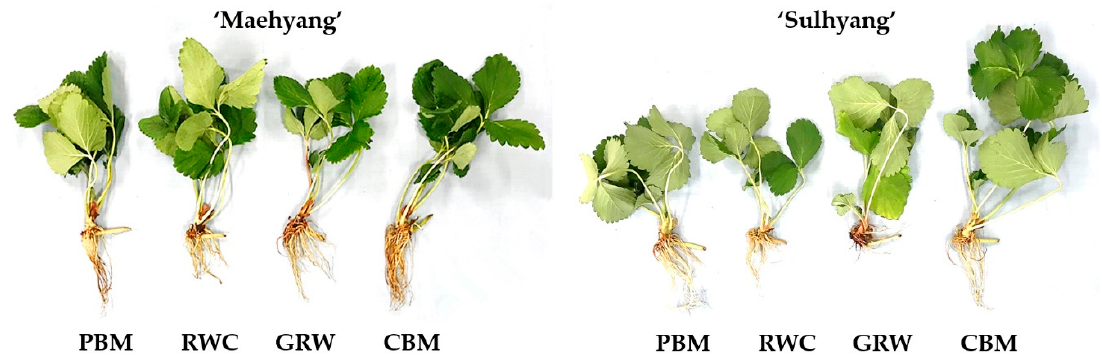
Figure 6. The effects of the growth medium on the morphology of strawberry ‘Maehyang’ and ‘Seolhyang’ daughter plants grown with a 12-day fogging. PBM, a peat moss-based mixture; RWC, rockwool cube; GRW, granular rockwool; and CBM, a coir-based mixture.